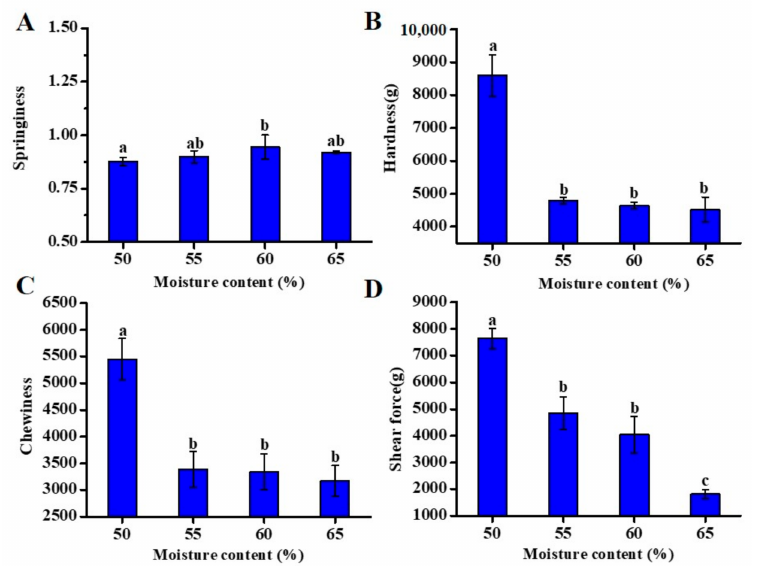
Figure 2. Effect of moisture content on the textural properties of fish filets: springiness ( A ), hardness ( B ), chewiness ( C ) and shear force ( D ). Different letters represent significant differences ( p <